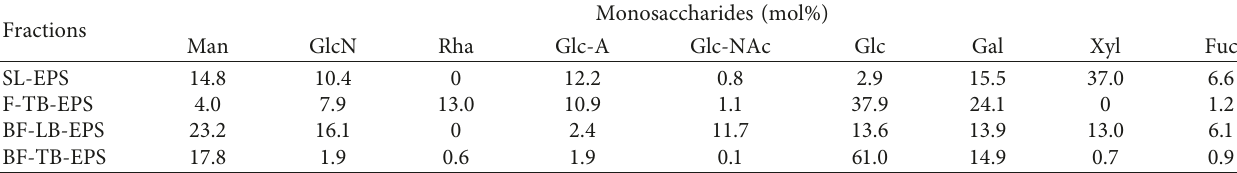
Monosaccharides